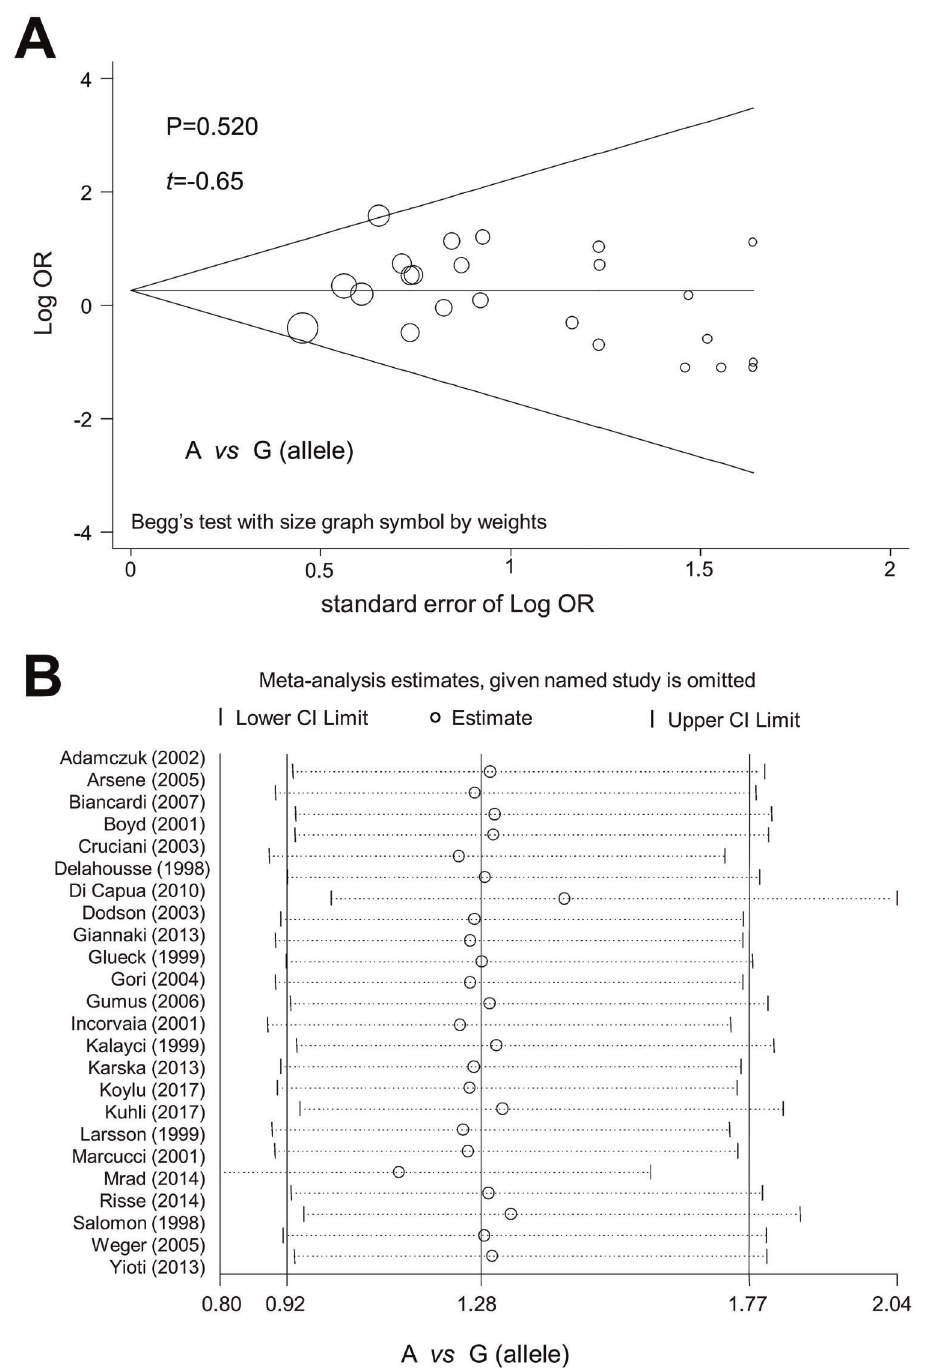
Figure 4. Publication bias plot of Begg ’ s test ( A ) and sensitivity analysis data ( B ) under the A vs G (allele) model. See Figure 2 for reference numbers of articles cited. OR: odds ratio; CI: con fi dence